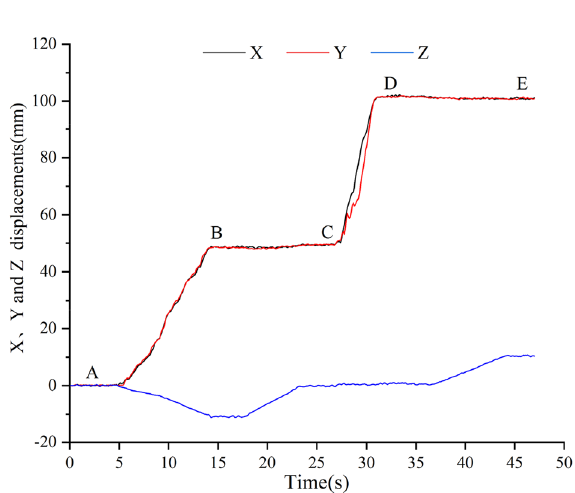
Figure 20. Variation curve of displacements in X, Y and Z directions (The figure was generated by Origin 2016 × 64 (https:// www. origi nlab. com/